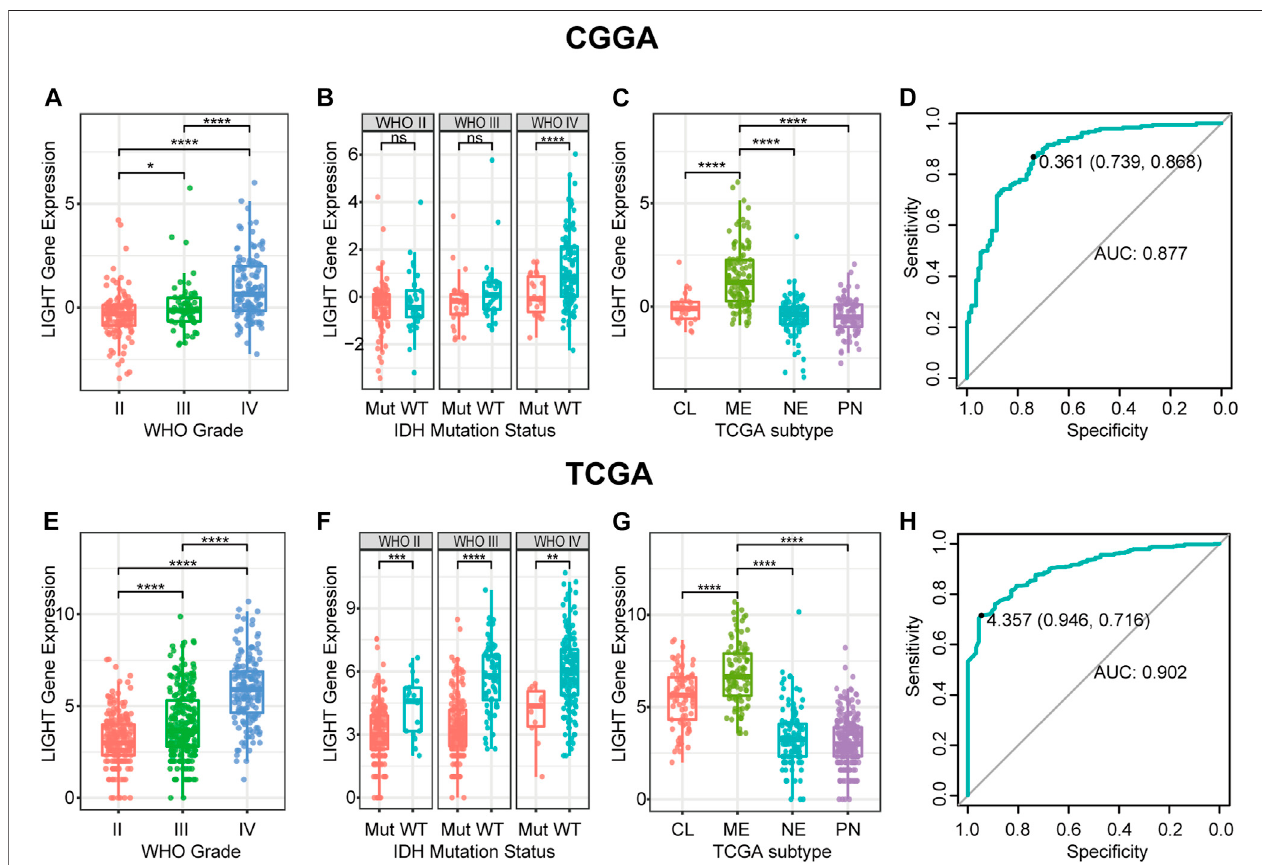
FIGURE1| LIGHTexpressioninCGGAandTCGAdatasetsaccordingtoWHOgrade (A , E) ,IDHmutationstatus (B , F) ,TCGAmolecularsubtype (C , G) ,andROC curves (D , H) for distinguishing mesenchymal subtypes. * indicates p value < 0.05, **indicates p value < 0.01, *** indicates p value < 0.001, and **** indicates p value <